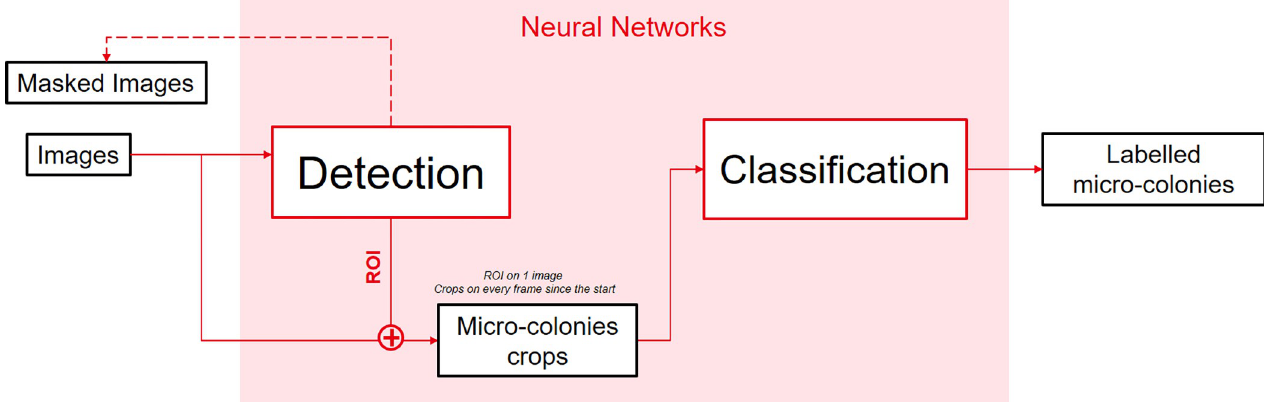
Fig 3. Global Deep Learning schematized architecture. Detection and classification are separated into two different tasks. The detection network takes 768 × 768 pixels sub-images and outputs regions of interest. The classification network uses candidate crop time-lapses as inputs and outputs a probability vector to label each